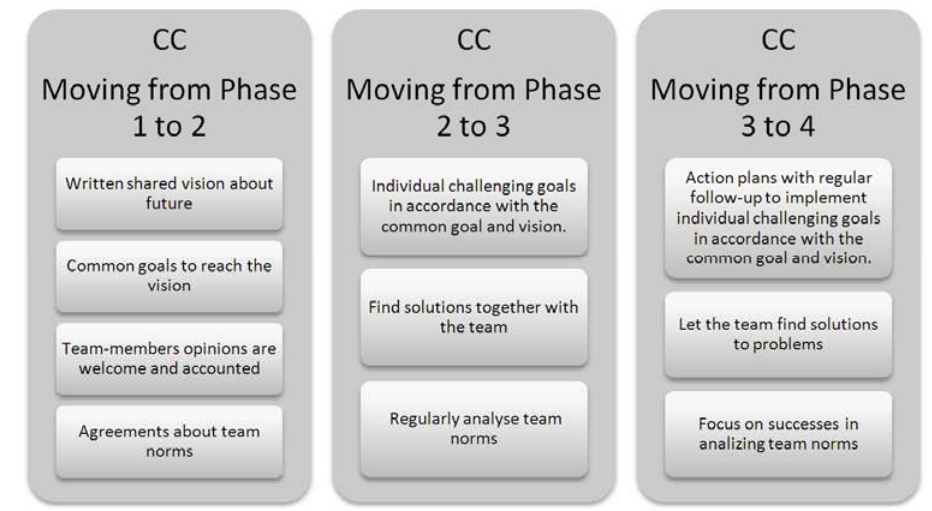
Fig. 5. Implications for team leaders regarding implementing a coaching culture in the leadership style based on the 3C